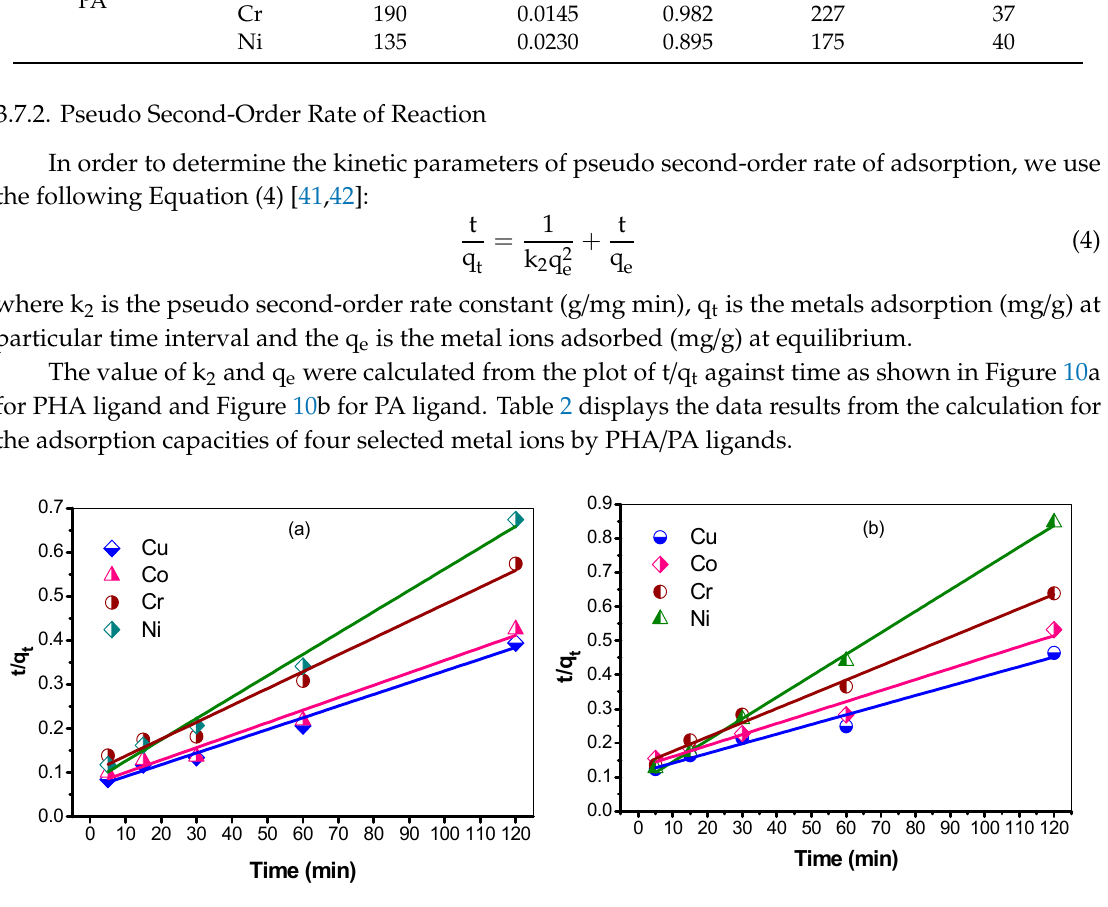
Figure 10. The kinetic character of pseudo second-order on the adsorption of metal cations by the jute cellulose-based polymer ligands: ( a ) PHA and ( b ) PA ligand; experimental variables: 0.5 g of ligands (PHA or PA), 15 mL of distilled water, 5 mL of pH 6 buffer solution, 5 mL of 0.2 M synthetic metals cations solution and stirred for 2 h. Table 2. Adsorption rates of the pseudo second-order model for transition metals by the polymer chelating ligand (PHA/or PA ligand).